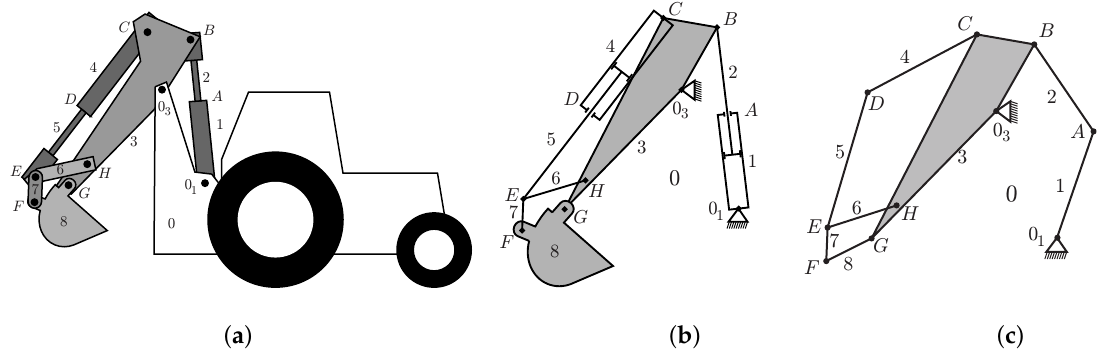
Figure 31. The mechanism of a backhoe ( a ) can be abstracted to a framework (see ( b ) and then ( c )) with a rigid block 3 and two vertices 0 1 ,0 3 pinned to the machine body 0. Figures courtesy of the mechanical engineer and geometer Offer Shai [80].